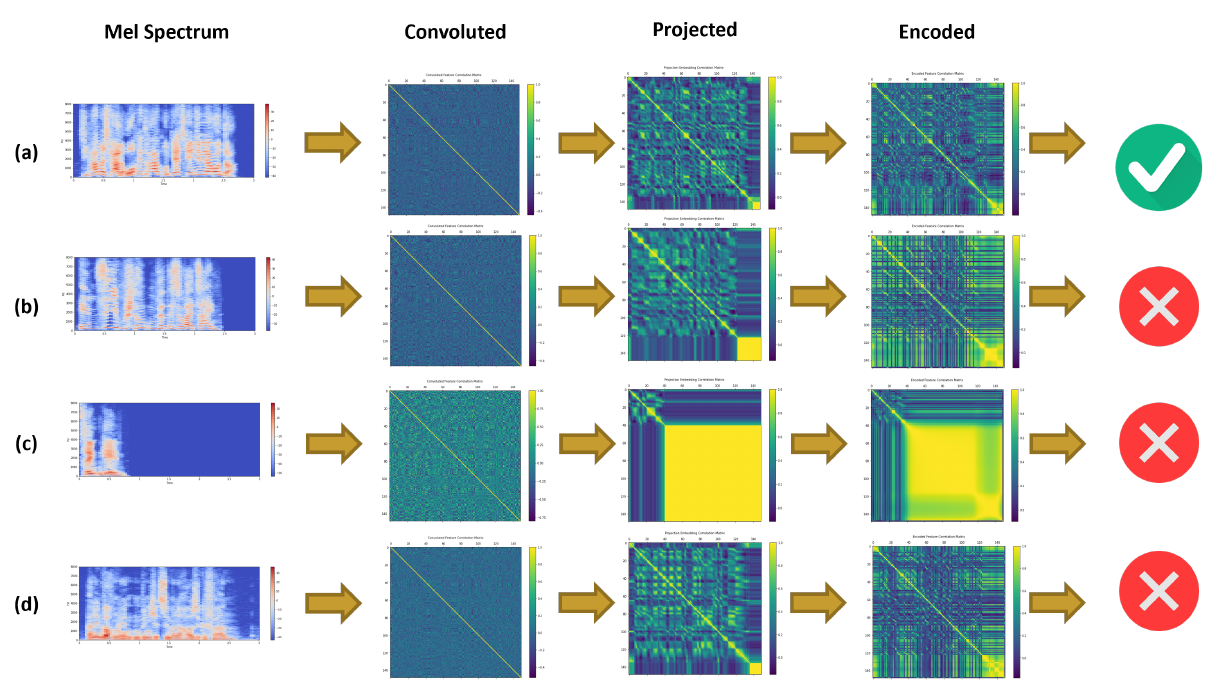
Figure 8. Correlation coefficients of E2ESER-CD using fine-training of XLSR with the LMET back-end network based on the Emo-DB dataset: ( a ) normal speech chunk, ( b ) chunk containing normal silence, ( c ) chunk containing mostly silence, and ( d ) chunk between speech. Note that the correct (green circle) and incorrect (red circle) signs are model results when compared with emotion labels. Please see the full resolution image in the supplementary material.